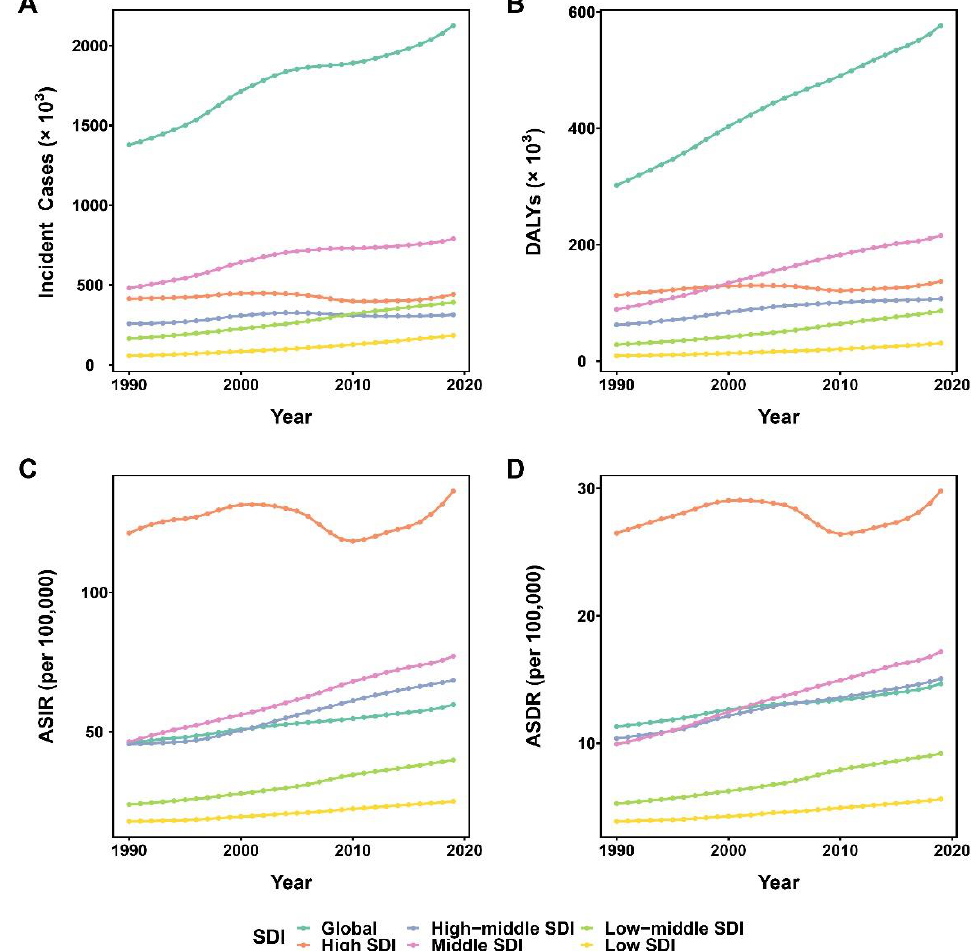
Figure 3. The changes in cases and ASR of PCOS in global and different SDI quintiles from 1990 to 2019. ( A ) Changes in incident cases of PCOS; ( B ) Changes in DALYs of PCOS; ( C ) Changes in ASIR of PCOS; ( D ) Changes in ASDR of PCOS. ASR, age-standardized rates; PCOS, polycystic ovary syn- drome; SDI, socio-demographic index; DALYs, disability-adjusted life years; ASIR, age-standard- ized incidence rate; ASDR, age-standardized disability-adjusted life years rate.